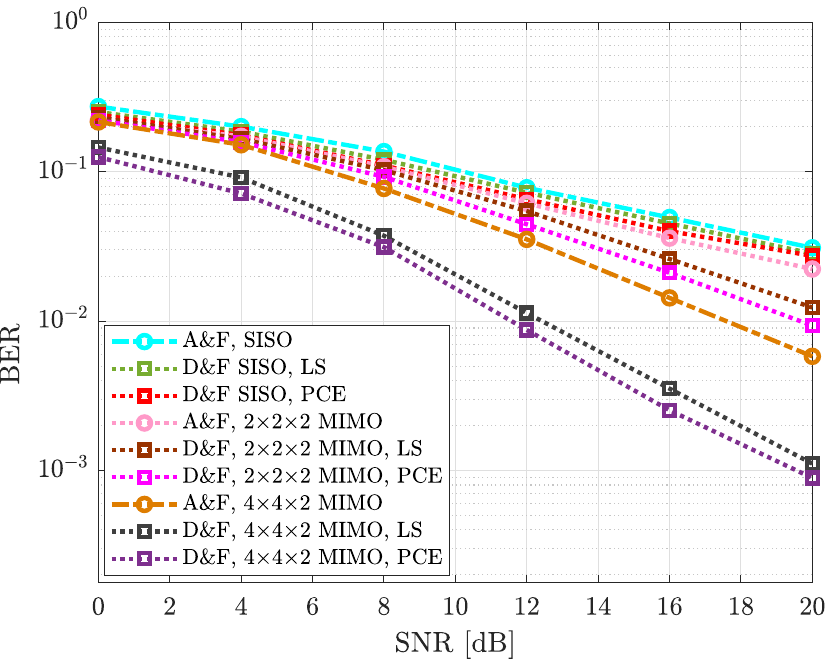
Figure 11. BER vs. SNR of the cooperative system; 256-QAM